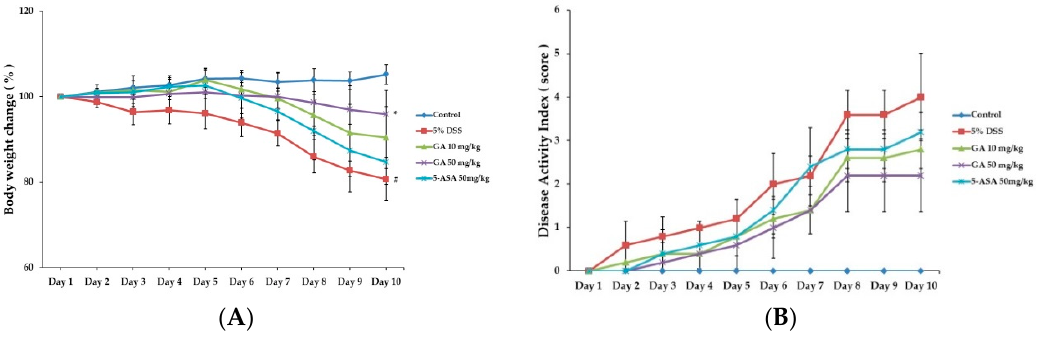
Figure 1. Effects of GA on clinical signs in DSS-induced colitis. ( A ) Body weight was measured at the same time on the experimental days; ( B ) Disease activity index score in the five study groups. Values represent mean ± S.E.M. ( n = 6). Data were analyzed by Student’s t -test ( # p < 0.05 vs. control and * p < 0.05 vs. DSS alone).